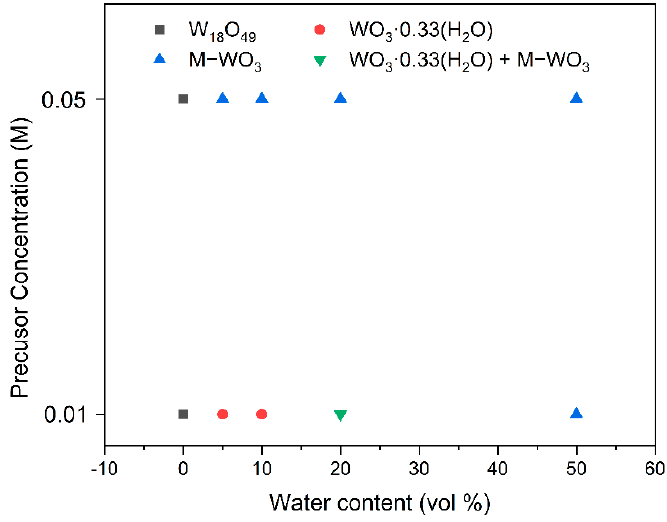
Figure 4. The effect of water content and precursor concentration on the crystal structure of as- synthesized powder.